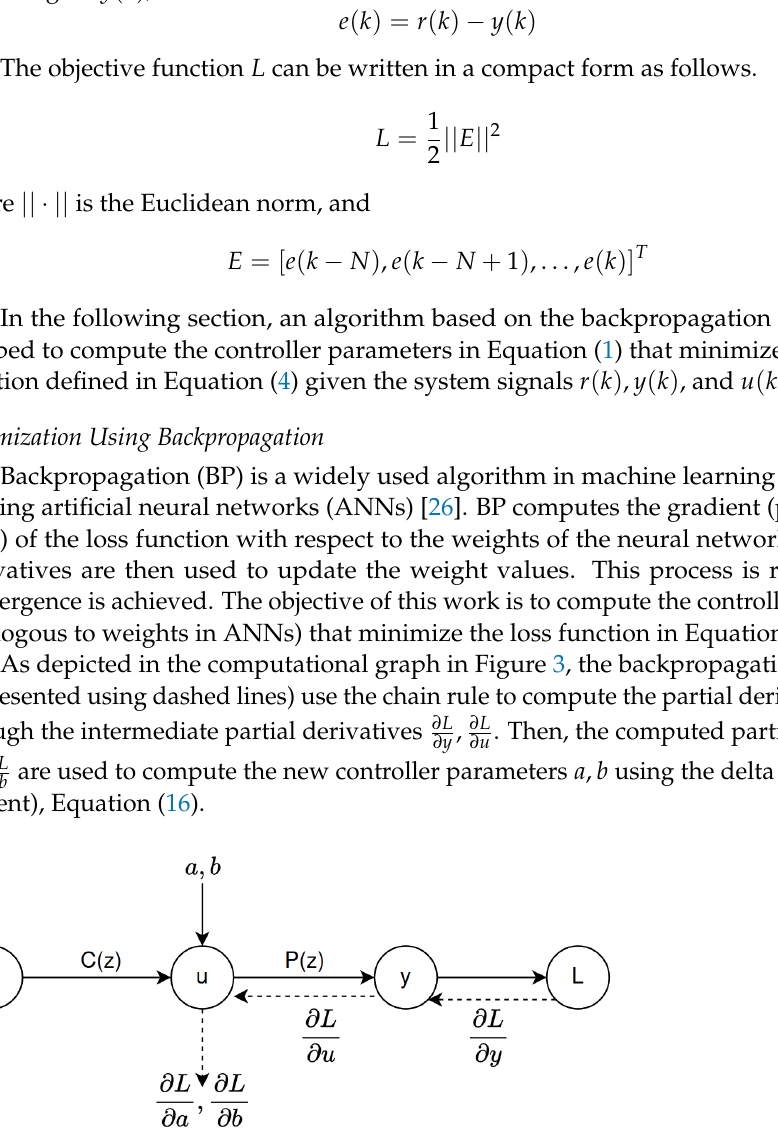
Figure 3. Forward and backward operations are used to compute the partial derivatives. Solid arrows represent forward propagation, and backpropagation is represented by dashed